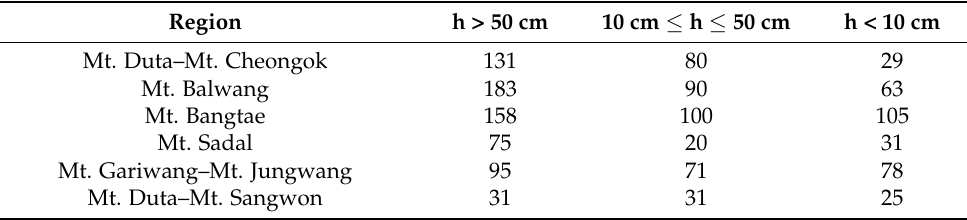
Table 5. Status of Abies nephrolepis young tree density by survey